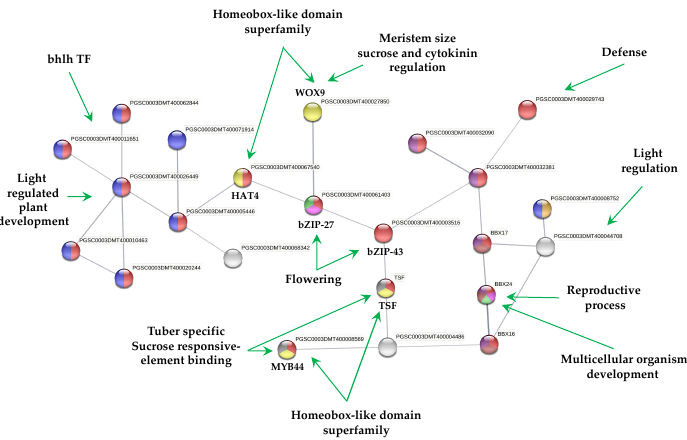
Figure 3. PPI network of up-regulated TFs derived using STRING database from transcriptomic-wide analysis of potato S. tuberosum with medium confidence (0.400). The figure represents a full network; the edges indicate both functional and physical protein